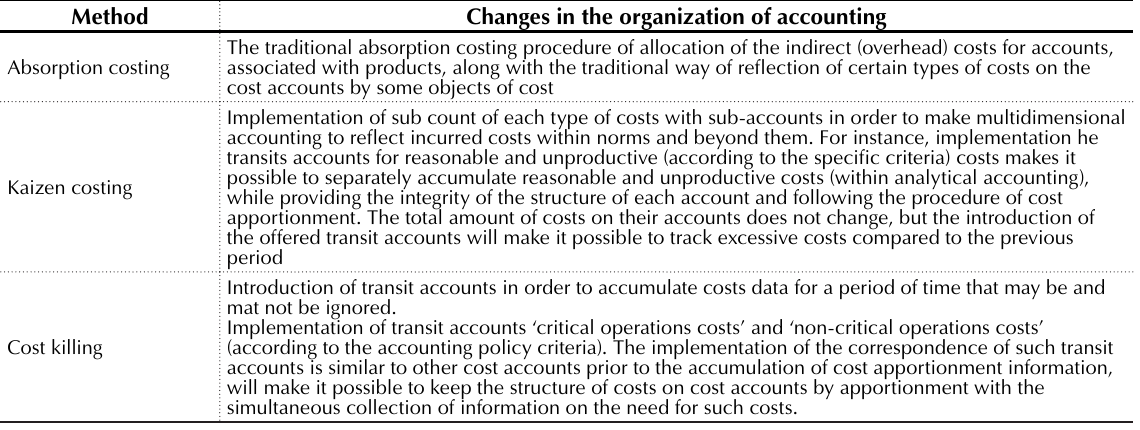
Table 6. Changes in the organization of enterprise accounting required for the use of absorption costing, kaizen costing, and cost killing in operational enterprise costs